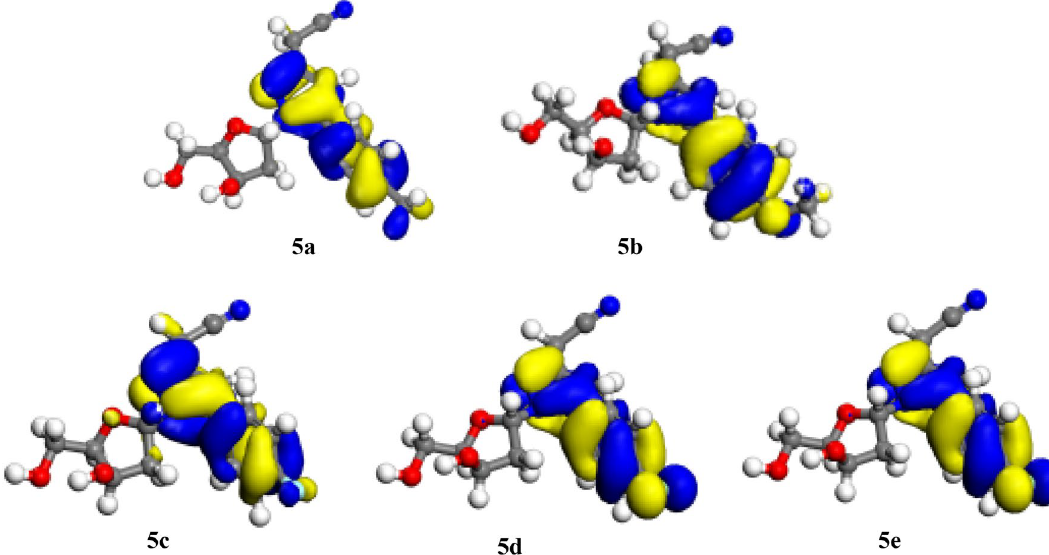
Figure 3. HOMO representations of the pyrazolylnucleosides 5a – e .